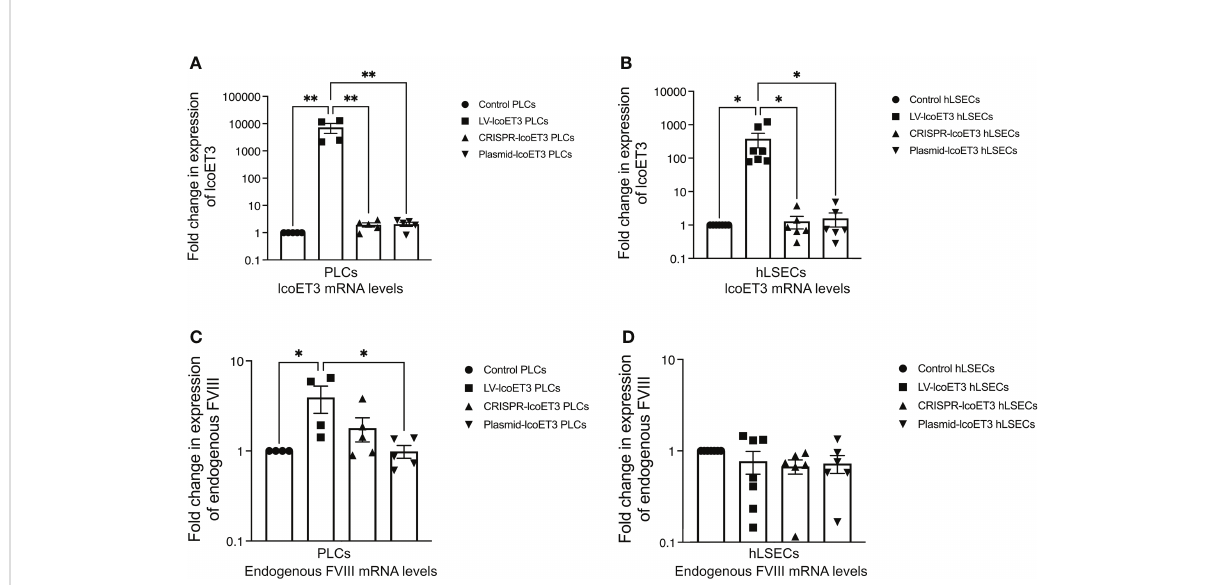
FIGURE 3 Detection of FVIII mRNA levels by RT-qPCR. Relative fold-change in expression of lcoET3 transgene (A, B) and endogenous FVIII mRNA (C, D) in gene-modi fi ed PLCs (A, C) and hLSECs (B, D) is presented in comparison to unmodi fi ed control after normalization to ampli fi cation of GAPDH in each respective sample. n = 5 for unmodi fi ed/control PLCs, n=4 for LV-lcoET3 PLCs, n = 5 for CRISPR-edited PLCs, n=5 for Plasmid-lcoET3- transfected PLCs; n = 6-8 for all hLSEC treatment groups. *p<0.05; **p<0.01.